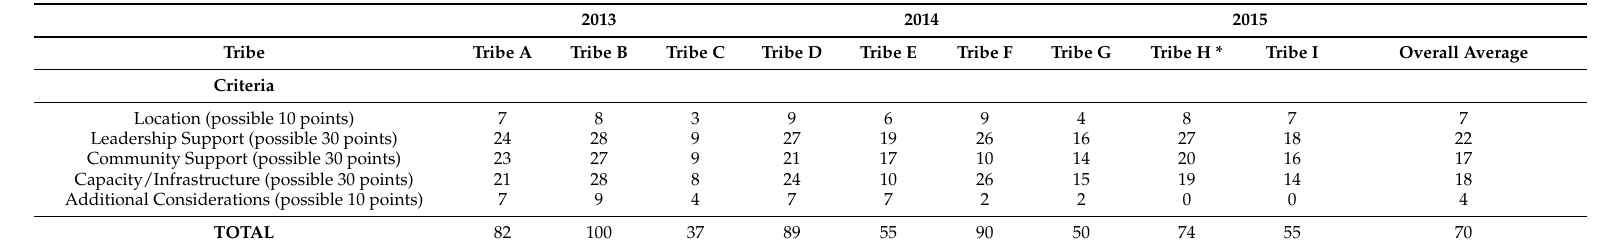
Table 3. Tribal Selection Criteria Scores for Tribes Selected for Site Visits (2013–2015).